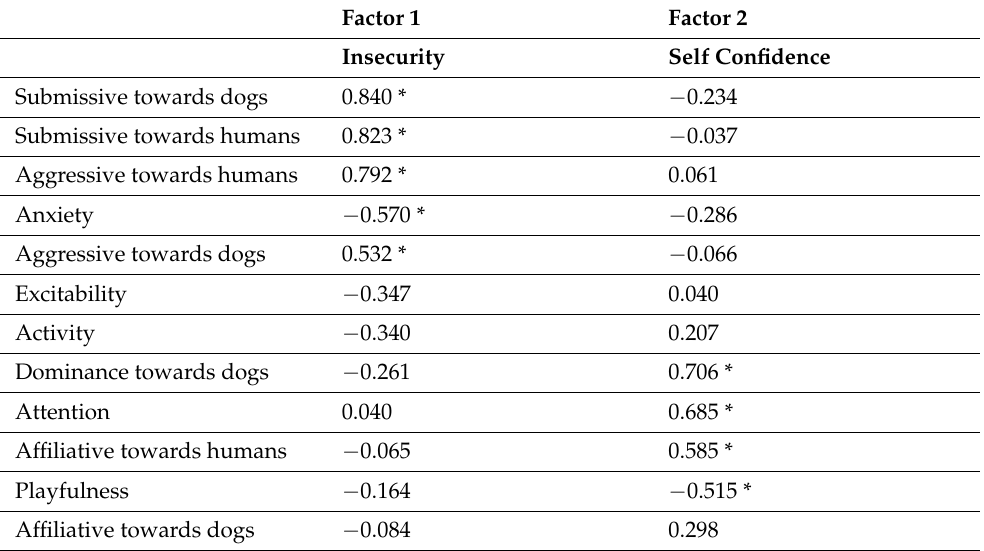
Table 2. Results from the PCA run on pre-adoption data. Factor 1 Factor 2 Insecurity Self Confidence 0.840 * −